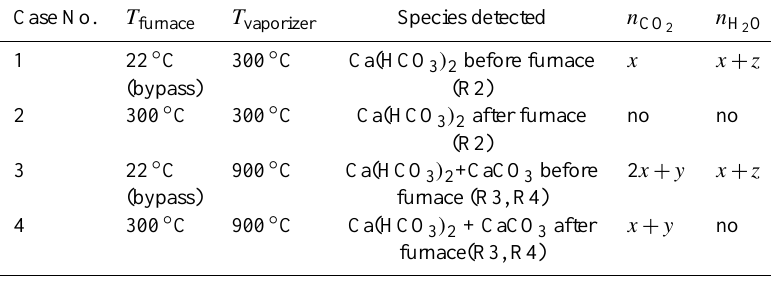
Table 1. Species detected at different temperatures T of tube furnace and Q-AMS vaporizer Case